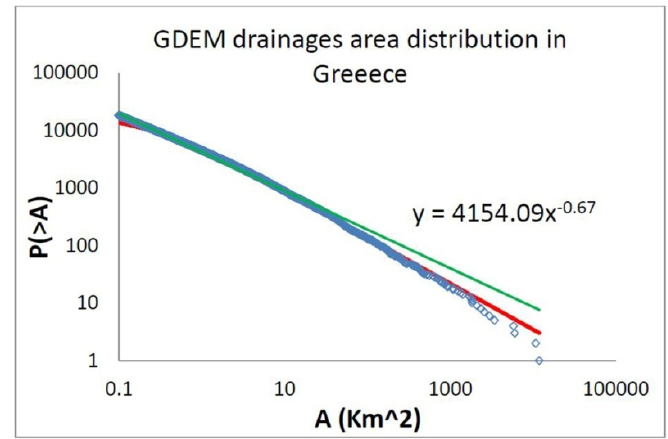
Appl. Sci. 2019 , 9 , x FOR PEER REVIEW 9 of 17 basins. For each one of the cases we have β ext ≈ 0.65 and β int ≈ 0.86 (see Figure 6a,b). For the case of External Hellenides a deviation of observation from power law is observed for large drainage areas, i.e., for A > 100 km 2 . Figure 5. The drainage area distribution for Greece. A power law fitting is presented with β all ≈ 0.67 (green line) along with the Q-exponential (red line) with Q ≈ 2.41 (see text). A power law (see Equation (6)) fits the data for both the data sets organized for the drainage areas in external and internal Hellenides, respectively, implying a hierarchical organization of drainage